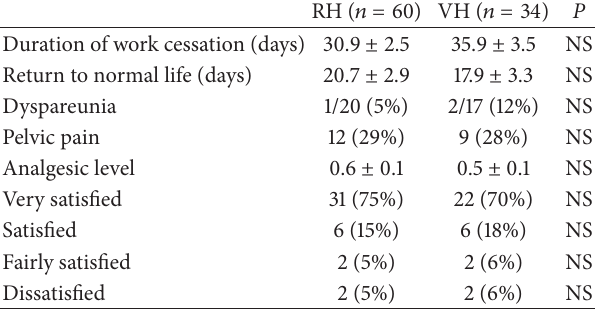
Table 4: Results of the questionnaire completed 2 months after surgery expressed as mean ± SD and number (%). RH ( 𝑛 = 60 ) VH ( 𝑛 = 34 )